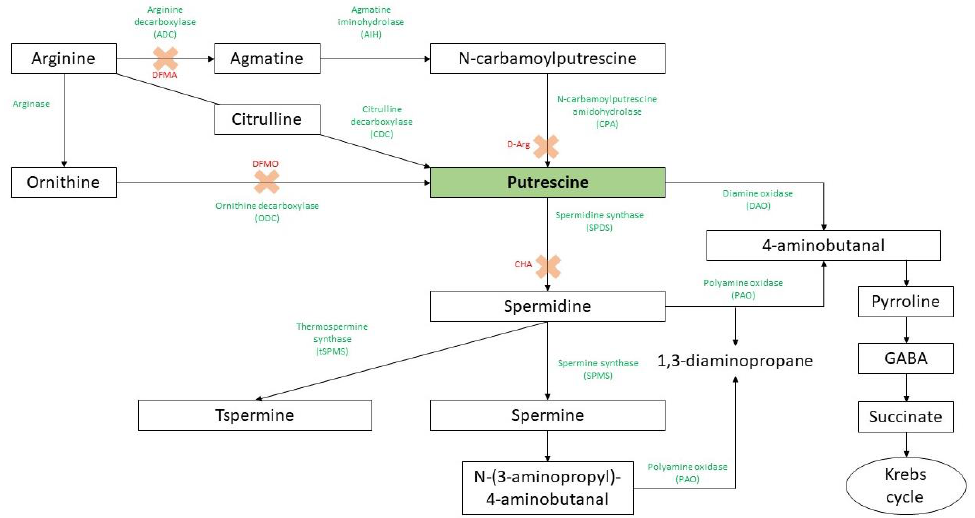
Figure 1. Putrescine biosynthesis and catabolism in plants. The green words indicate the enzyme activities, and the red ones followed by a cross are referred to competitive enzyme inhibitors (DFMA: difluoromethylarginine; DFMO: difluoromethylornithine; D-Arg: D-Arginine; CHA: cyclohexy- lamine). Adapted from Wojtasik et al. [20] and Chen et al.